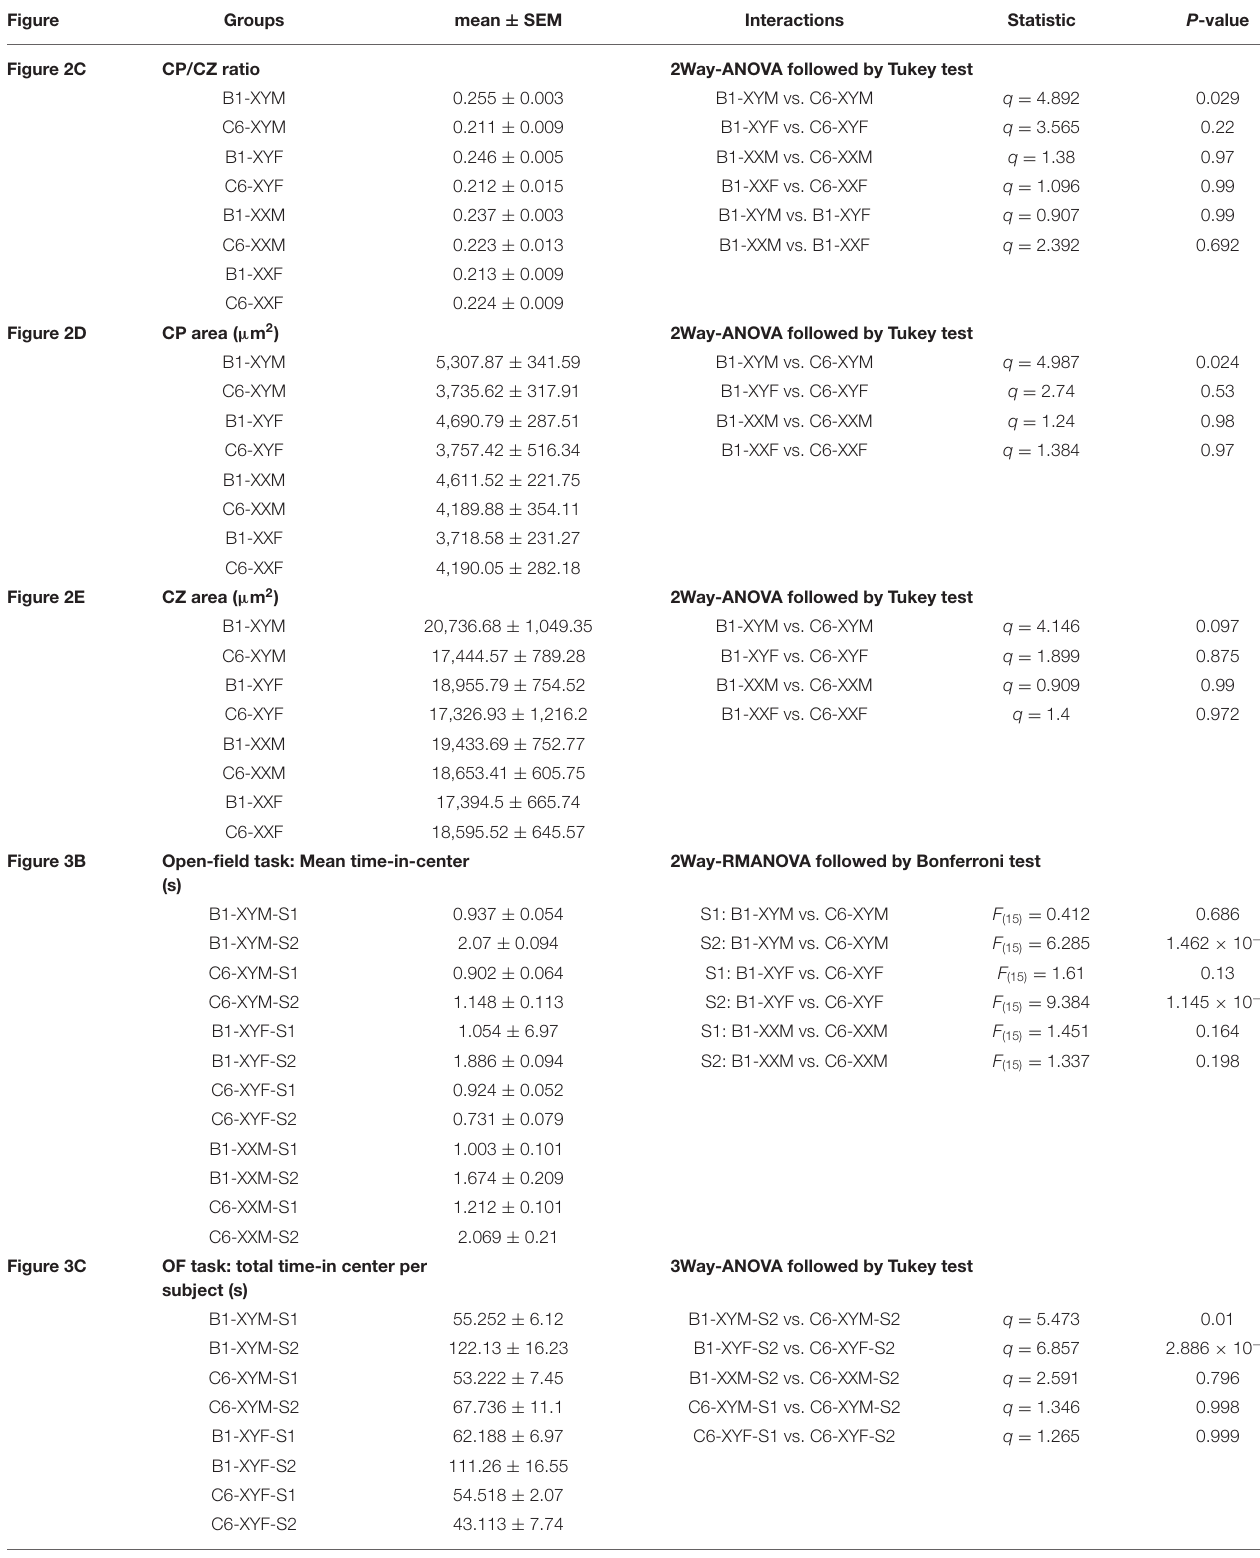
TABLE 1 | Statistical analysis for the parameters presented in the figures. Figure Groups mean ± SEM Interactions Statistic P -value Figure 2C